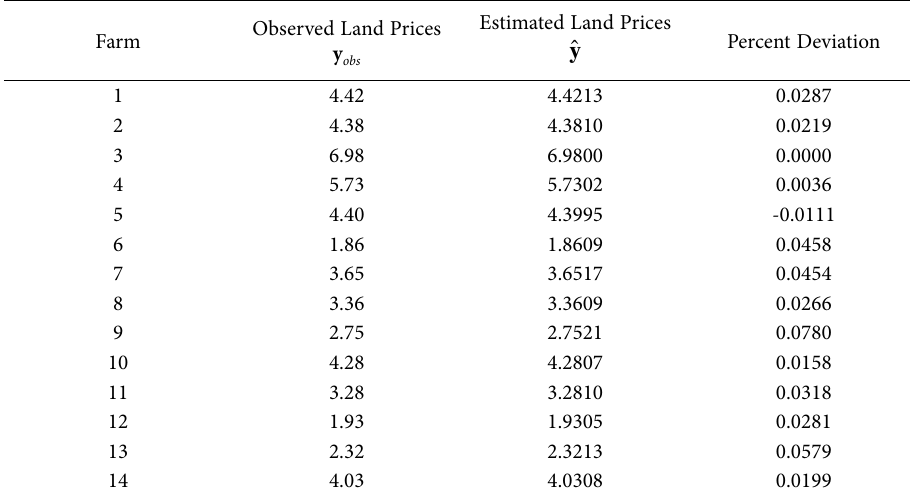
Table 6. Deviation of ˆ y from y obs